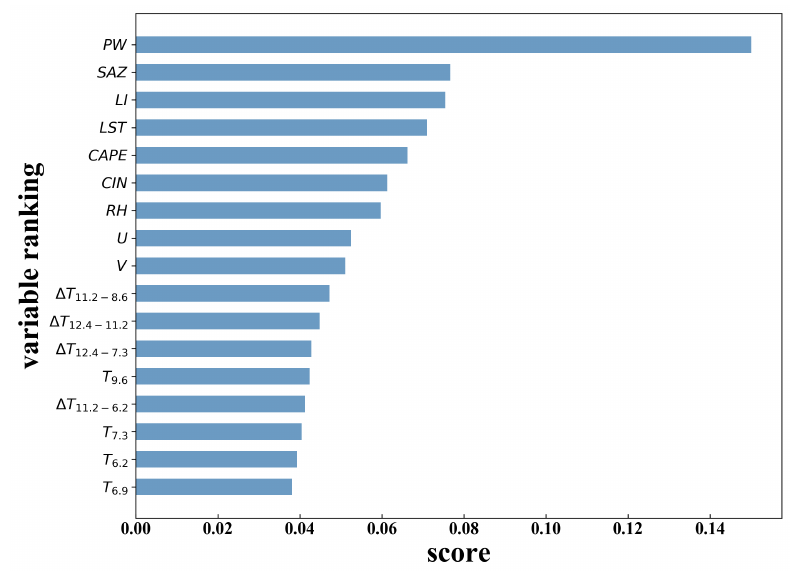
Figure 4. The ranking of the predictor variable in the RF model for rain area